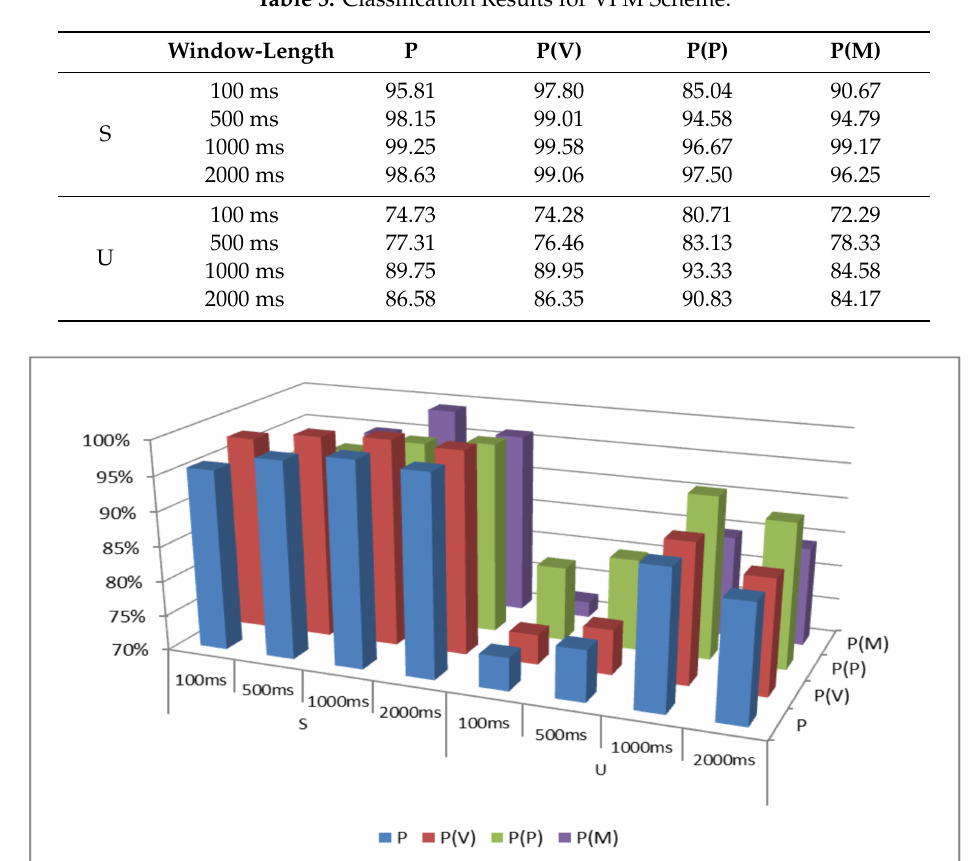
Figure 4. Classification Results for VPM